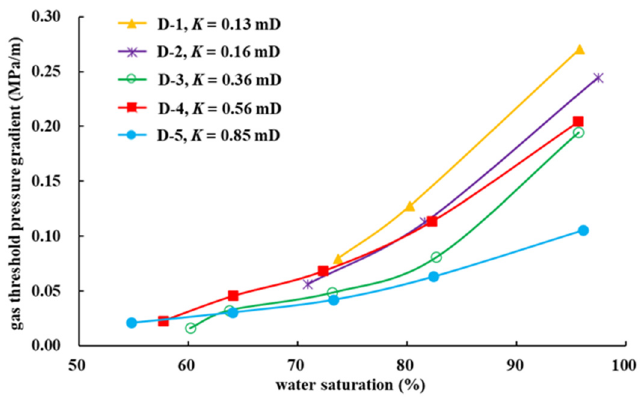
Figure 8. The relationship between TPG and water saturation.